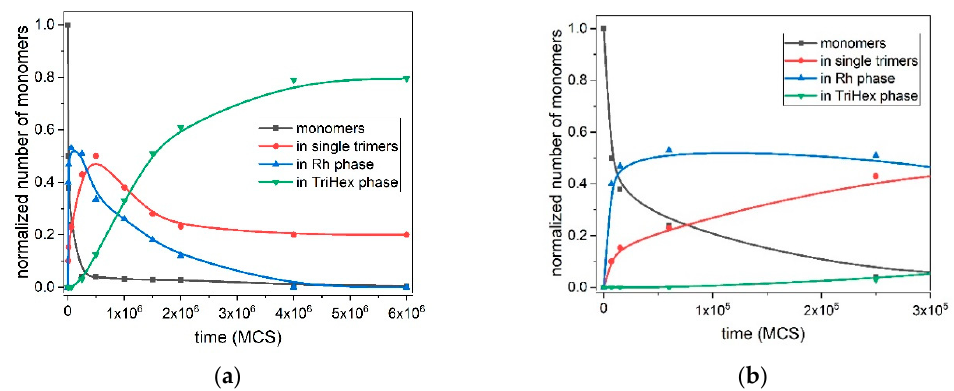
Figure 7. Kinetics of all processes involved in the polymorph transition from the Rh to TriHex phase at T* = 0.1: up to 6 × 10 6 MCS. ( a ). Monomers (black) are used as building units of the Rh phase (blue) and stable trimers (red); the latter serve as a second source of building units for the TriHex phase (green). The simulation points are averaged over 10 simulation runs and fitted by a spline curve. Initial stages up to 3 × 10 5 MCS are shown in ( b ). It should be noted that the term “time” is conventional; it refers to the number of the performed Monte Carlo steps (sweeps), and not to ordinary